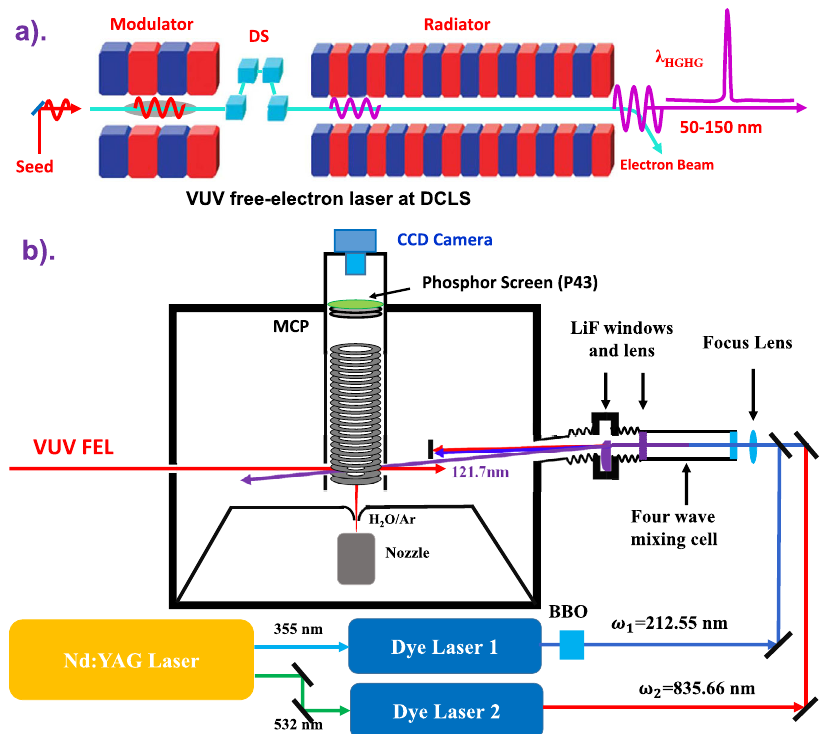
Fig. 1 Schematic diagram of the experimental setup. a Schematic of the VUV free-electron laser (VUV FEL) beamline at the Dalian Coherent Light Source (DCLS). b The arrangement of VUV-pump and VUV-probe time-sliced velocity-map imaging (TSVMI) system for the water photochemistry. Tunable VUV pumping source ( λ 1 ~ 100 – 112 nm) comes from VUV FEL beamline, and the fi xed VUV probing light ( λ 2 = 121.7 nm) is generated by the two-photon resonance-enhanced four-wave mixing ( ω ( λ 2 ) = 2 ω 1 – ω 2 ) scheme with dispersing the fundamental radiations ( ω 1 and ω 2 ) from the direction of the VUV